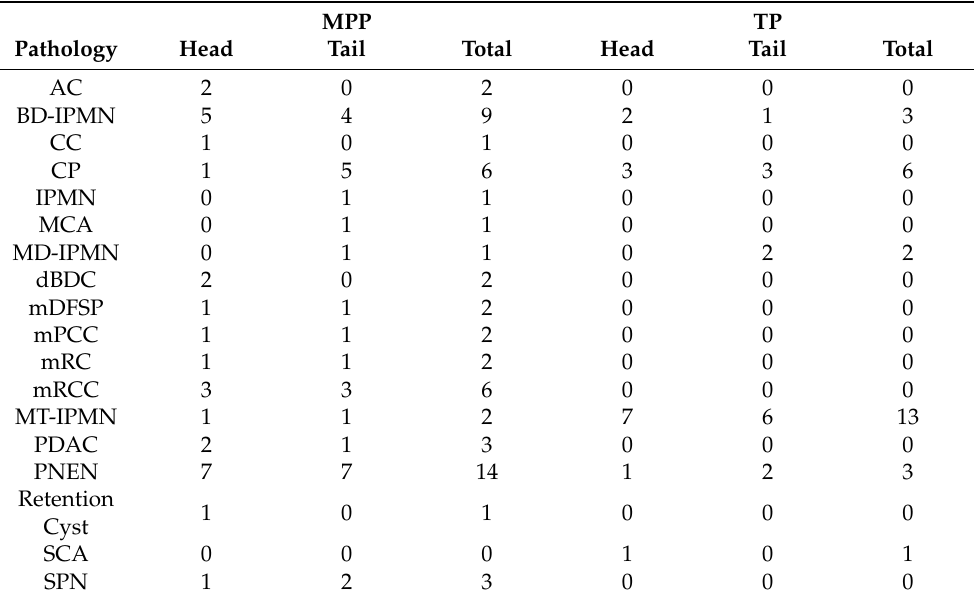
Table A3. Frequency of pathologies by location and surgical